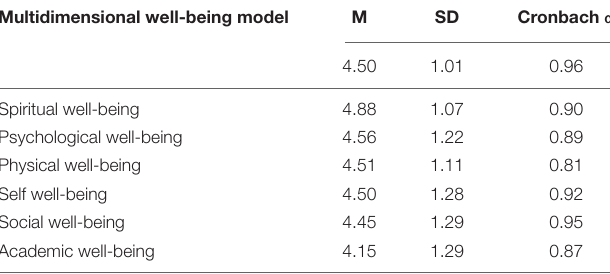
TABLE 3 | Means, SDs, and Cronbach α of six dimension of well-being.